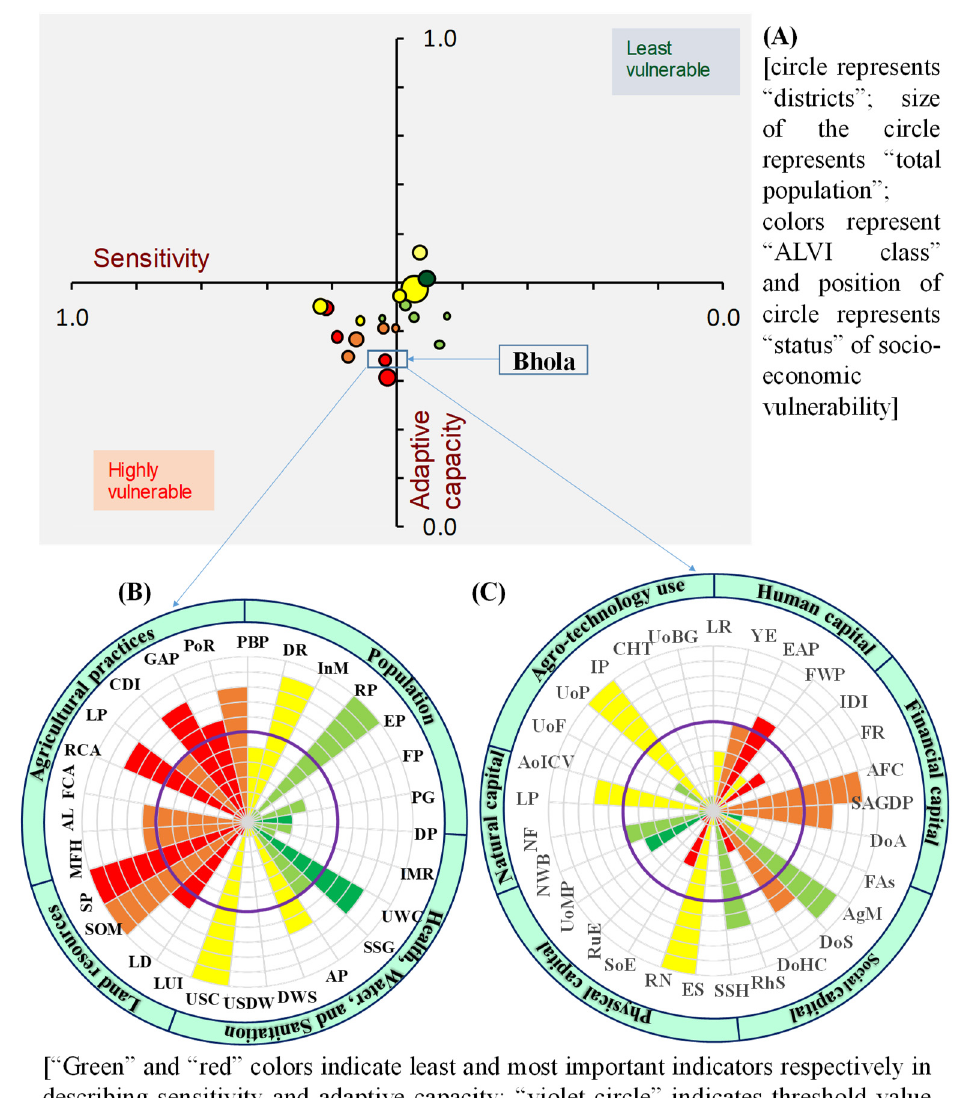
Figure 5. Decision matrix for entire coastal region incorporating 19 coastal districts by plotting sensitivity indices against adaptive capacity indices ( A ) and visualization of drivers and buffers of both Sensitivity and adaptive capacity components of a representative district on the circumplex charts ( B ) and ( C ), respectively, for intervention planning.